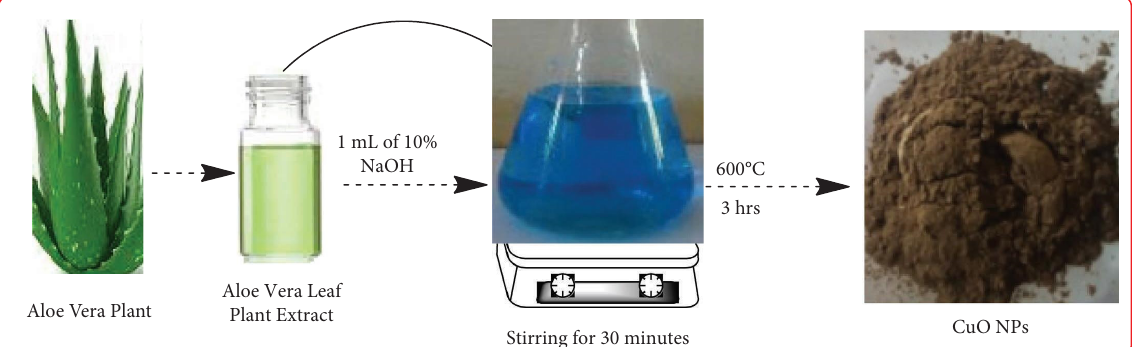
Figure 4: Synthesis of CuONPs using aloe vera leaf